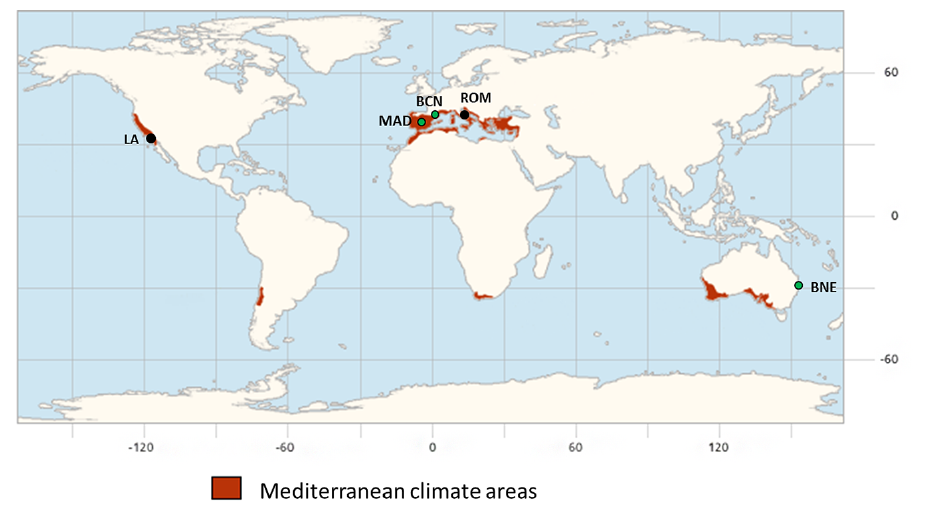
Figure 1. Location of the cities selected for the study. The 3 main cities Barcelona (BCN), Madrid (MAD) and Brisbane (BNE) are marked in green, whereas the supporting cities of Los Angeles (LA) and Rome (ROM) are shown in black. The cities of BCN, MAD, ROM and LA are located in Mediterranean climate regions, whereas BNE has a humid subtropical climate. Image source: US National Park Service California Mediterranean Research Learning